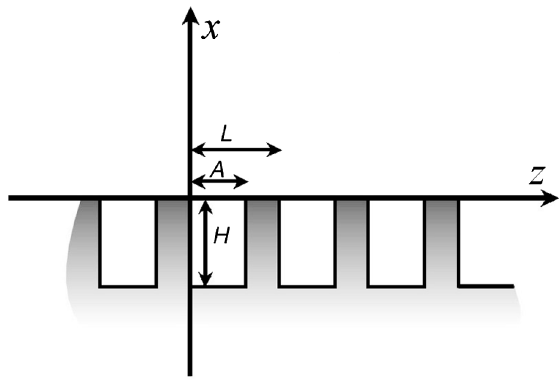
FIG. 1. Geometry of grating structure, viewed from the